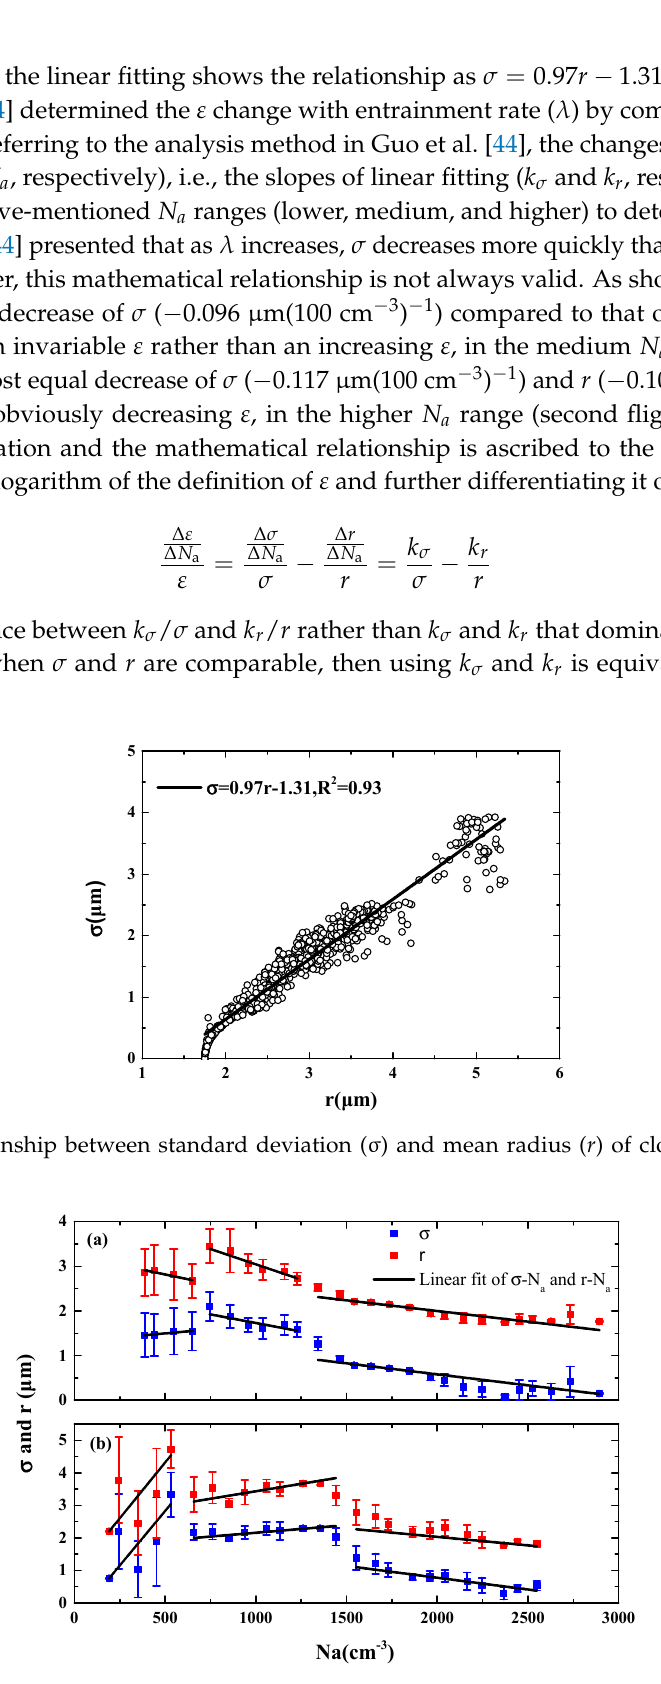
Figure 6. Standard deviation ( σ ) and mean radius (r) of cloud droplet size distribution vs aerosol number concentrations ( N a ). The black lines are linear fittings of σ − N a and r − N a in the three ranges of N a . ( a ) and ( b ) are for the first and second flights,